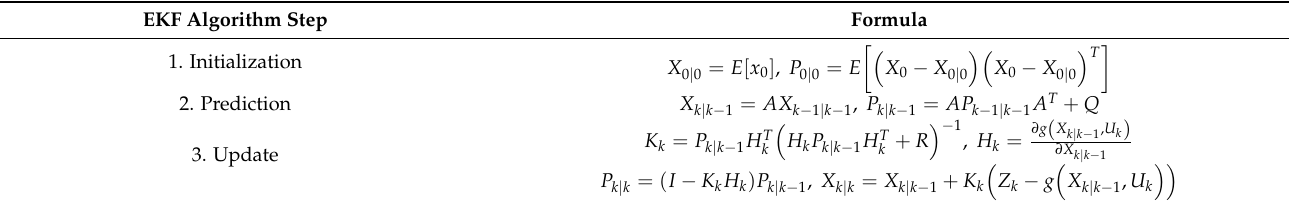
Table 1. The process of the